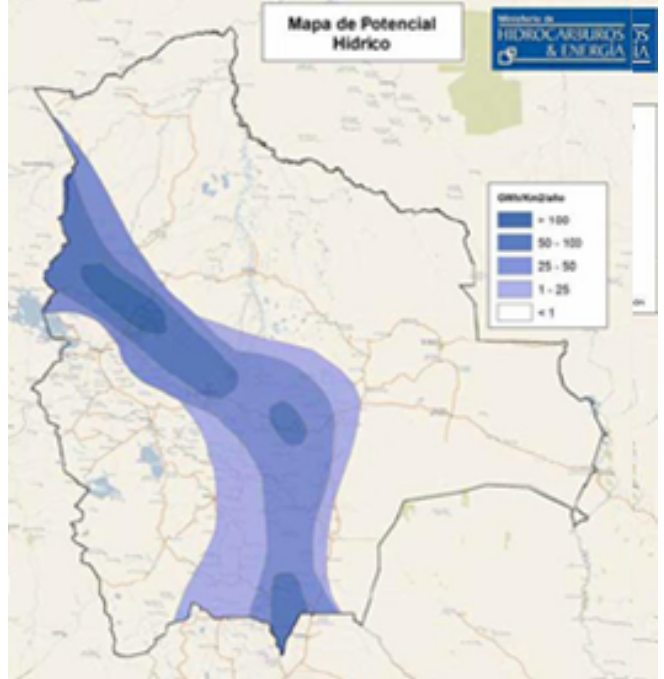
Figure 9. Hydroelectric energy potential [53].